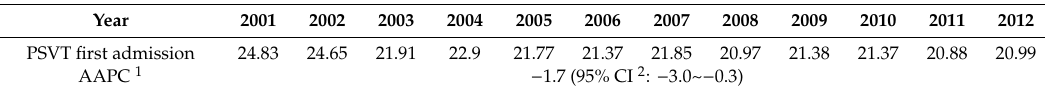
Table 2. Annual incidence of PSVT-related admissions (1 / 100,000).